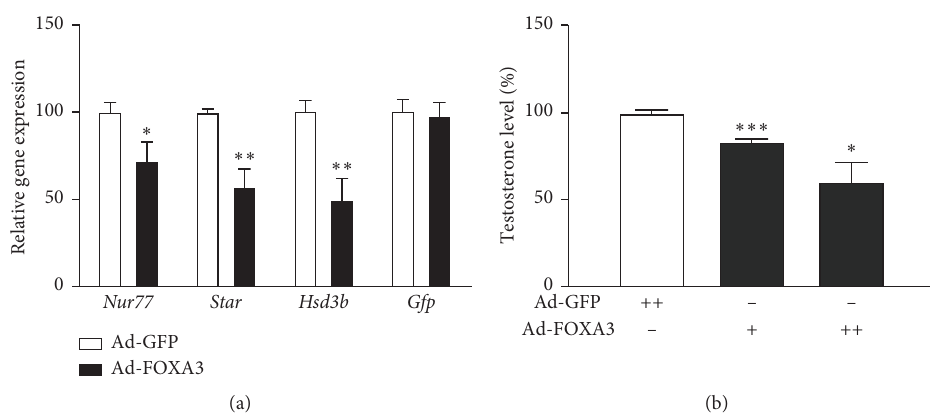
Figure 6: FOXA3 represses cAMP-induced expression of steroidogenic genes in primary Leydig cells. mRNA expression of steroidogenic genes in primary Leydig cells (A). Mouse primary Leydig cells were transduced with Ad-FOXA3 or Ad-GFP as control. After wash, the cells were further cultured for 48h that included 4h of cAMP (200 μ M) induction. The gene expression level was normalized to that of GAPDH. Testosterone production was significantly reduced by FOXA3 (B). Cells were transduced in a similar manner and maintained in 200 μ M of cAMP for 48h Culture medium was harvested for RIA assay. The t -test was performed to analyze statistical significance. ∗ P < 0 . 05; ∗∗ P < 0 . 0; ∗∗∗ P < 0 .